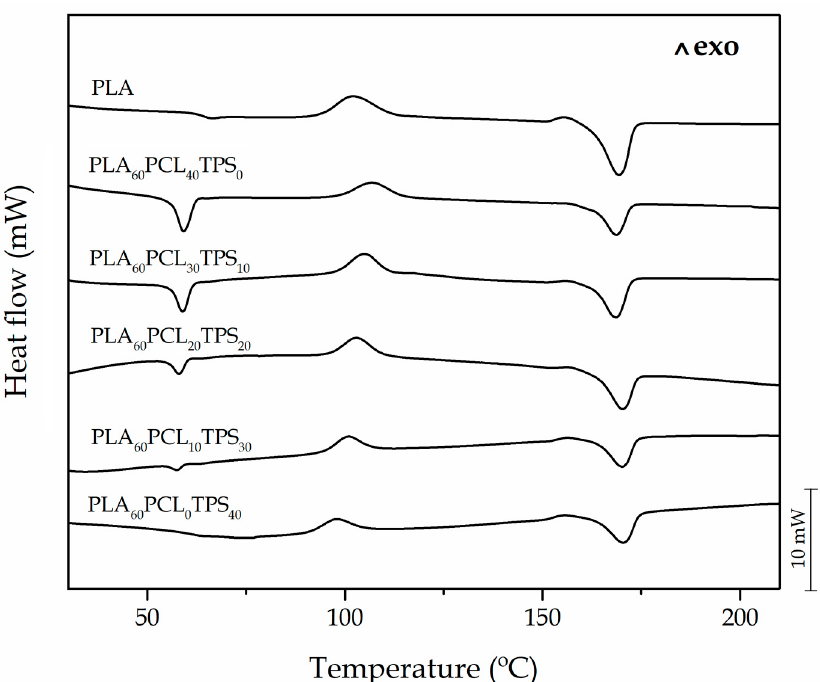
Figure 5. Comparative plot of the differential scanning calorimetry (DSC) curves of the polylactide (PLA), poly( ε -caprolactone) (PCL), and thermoplastic starch (TPS) blend pieces.